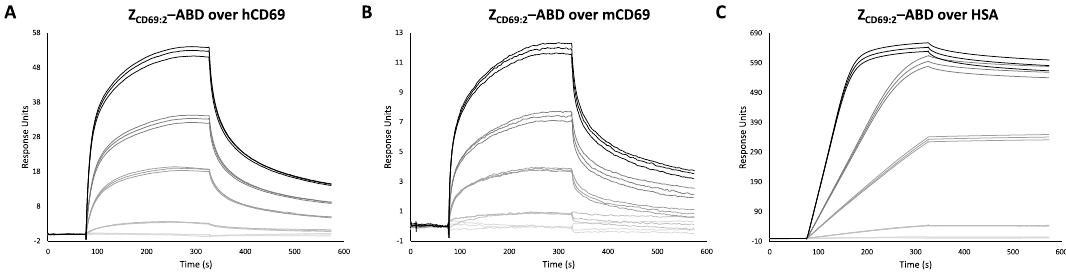
Figure 1. SPR sensorgrams showing the binding of H 6 -Z CD69:2 -ABD to ( A ) human CD69, ( B ) murine CD69 and ( C ) human serum albumin at different concentrations (1 nM, 5 nM, 25 nM, 50 nM and 100